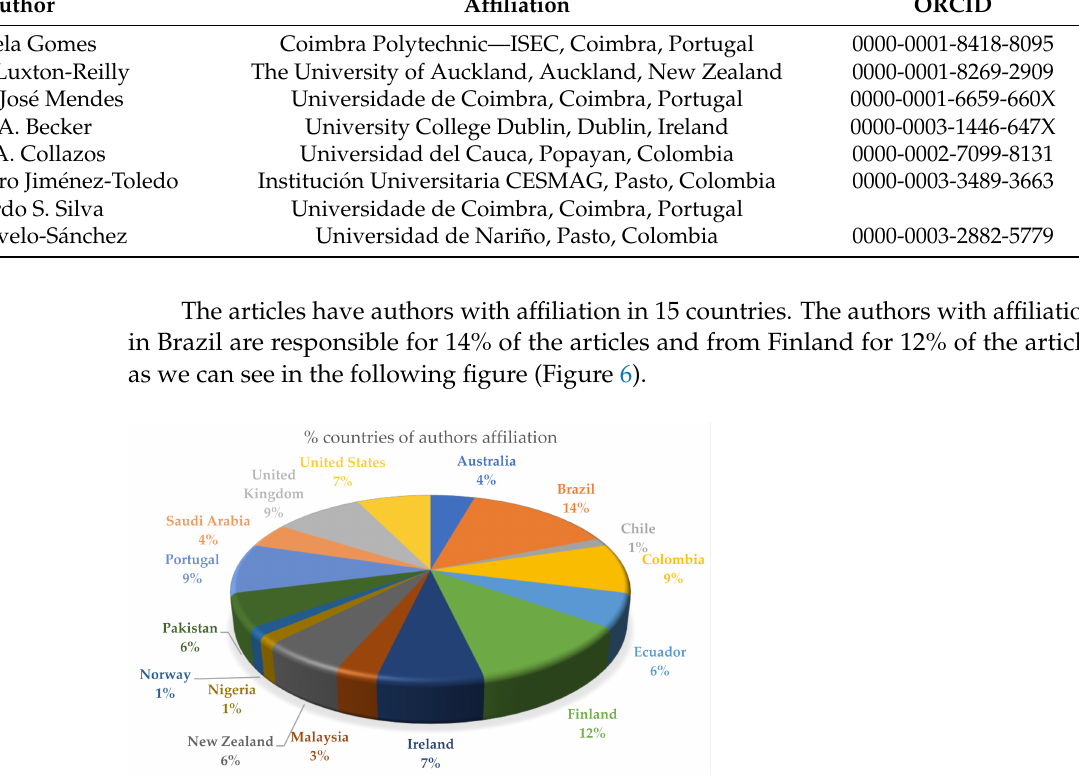
Figure 6. % Countries of authors